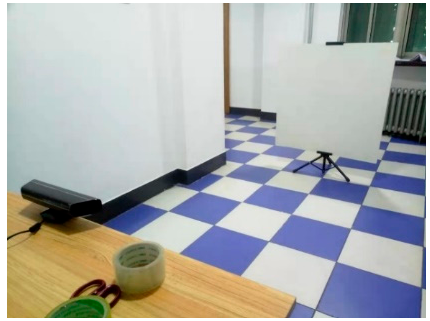
Figure 4. Test equipment.